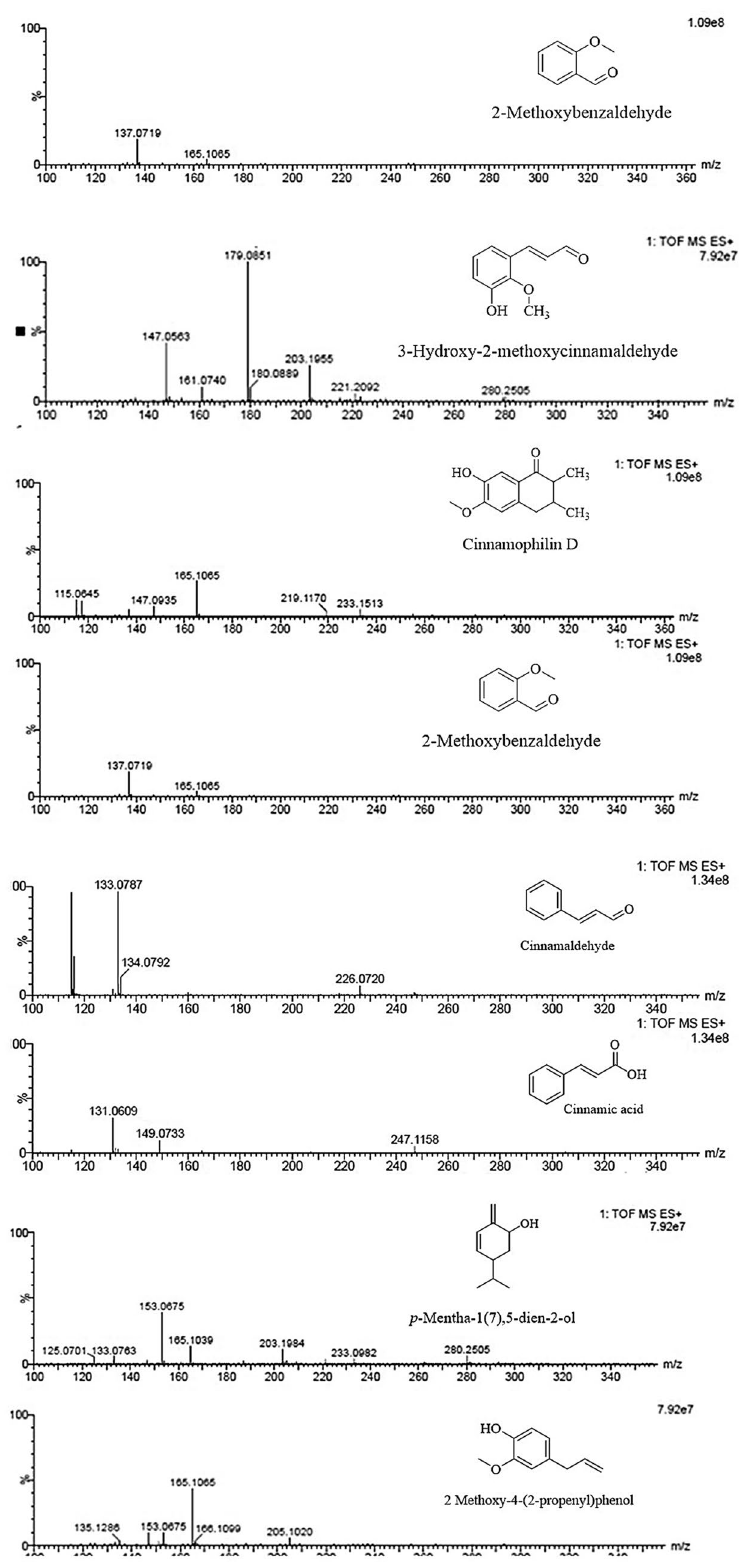
Figure 1. MS spectrums showing the secondary metabolites identified from cinnamon